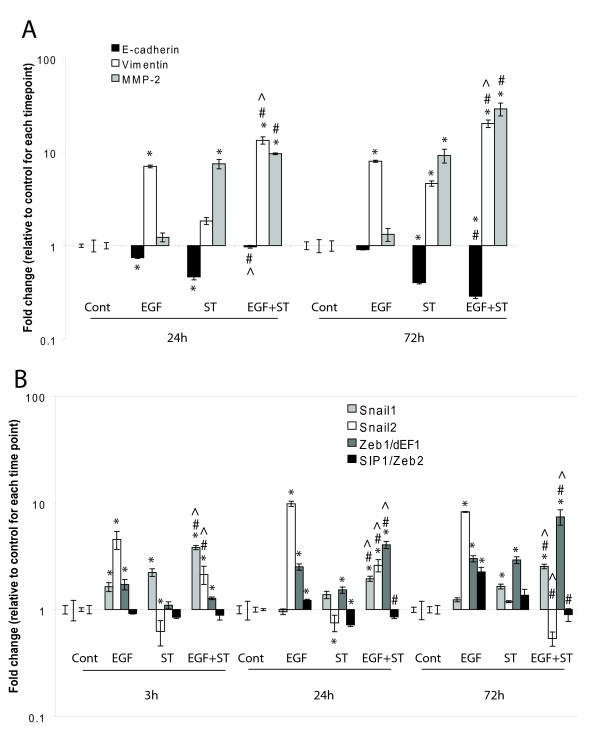
QRT-PCR of PMC42-LA cells treated for 72 h with 10 ng/ml EGF, 40 nM ST or both. Control: untreated (A) E-cadherin mRNA expression plotted against increased expression of hallmark mesenchymal genes MMP-2 and vimentin. (B) Comparison of expression of four E-cadherin repressor genes in the treatment regime used in A. Error bar values are standard error. Significance was set at p </= 0.05. * symbol indicates a statistically significant difference from the control within each time point. In the combined treatment, ^ and # indicate statistical significance from ST and EGF individual treatments, respectively, within each time point.